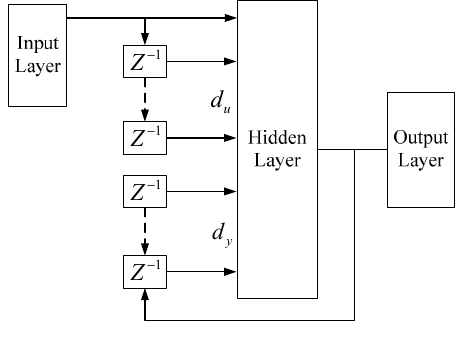
Figure 19. Structure of NARX. Figure 20. Structure of